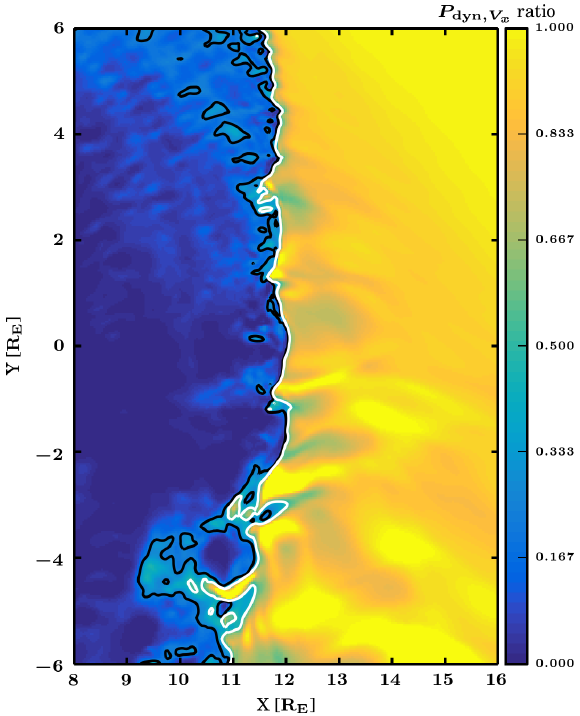
Figure 2. Color coding shows the dynamic pressure calculated us- ing the X component of velocity, v X , divided by the solar wind dy- namic pressure using the solar wind v X . The black contour shows where this Plaschke criterion exceeds 0.25, and white shows where it exceeds 0.5, as defined in Plaschke et al.